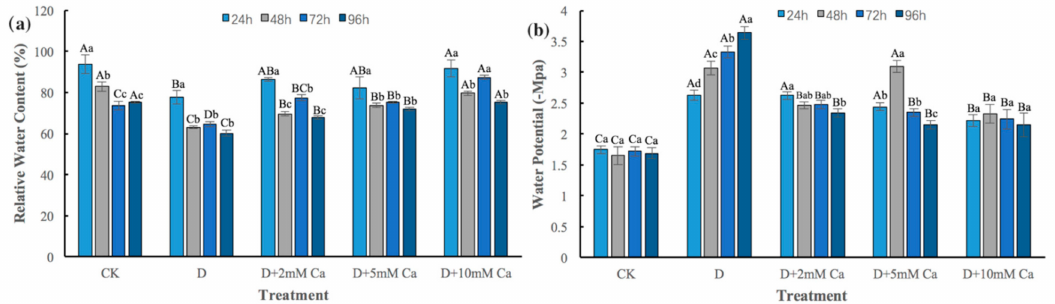
Figure 1. E ff ects of exogenous calcium on the relative water content ( a ) and water potential ( b ) of H . bodinieri. under drought stress. Note: Ck: treatment 1 (control); Drought: treatment 2; Drought + 2 mM Ca: treatment 3; Drought + 5 mM Ca: treatment 4; Drought + 10 mM Ca: treatment 5. Di ff